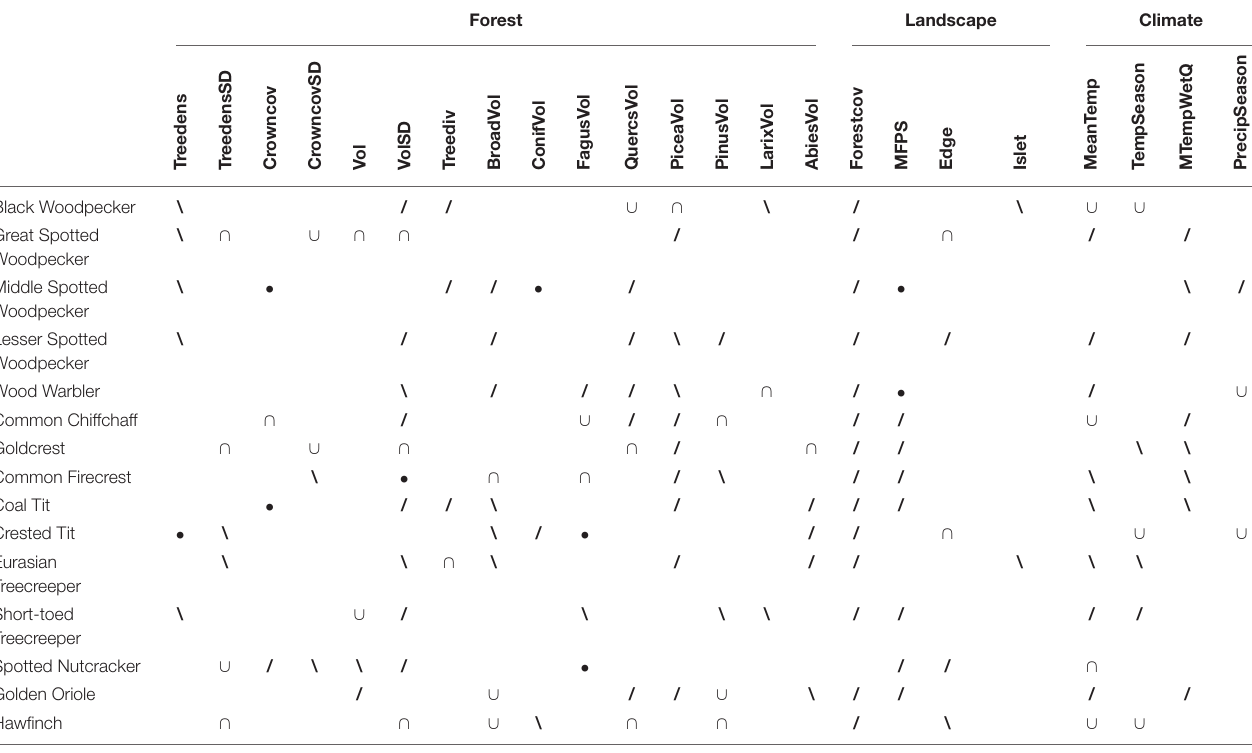
TABLE 4 | Predictors used in each of the species’ niche models, and type of response of each species to each predictor.